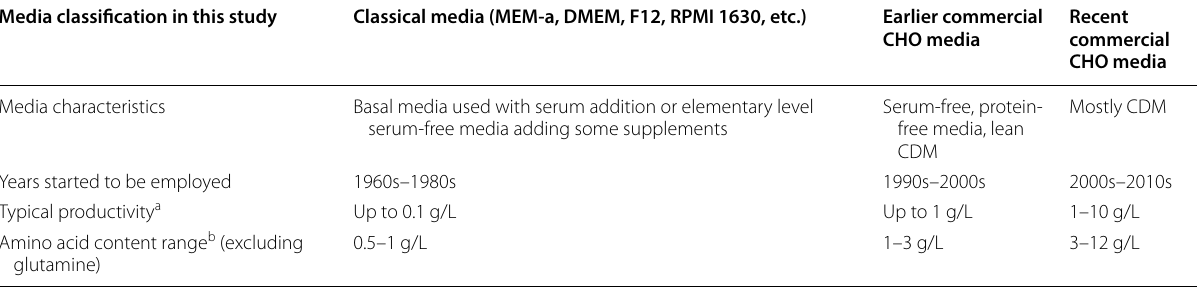
Table 1 Media features and amino acid content